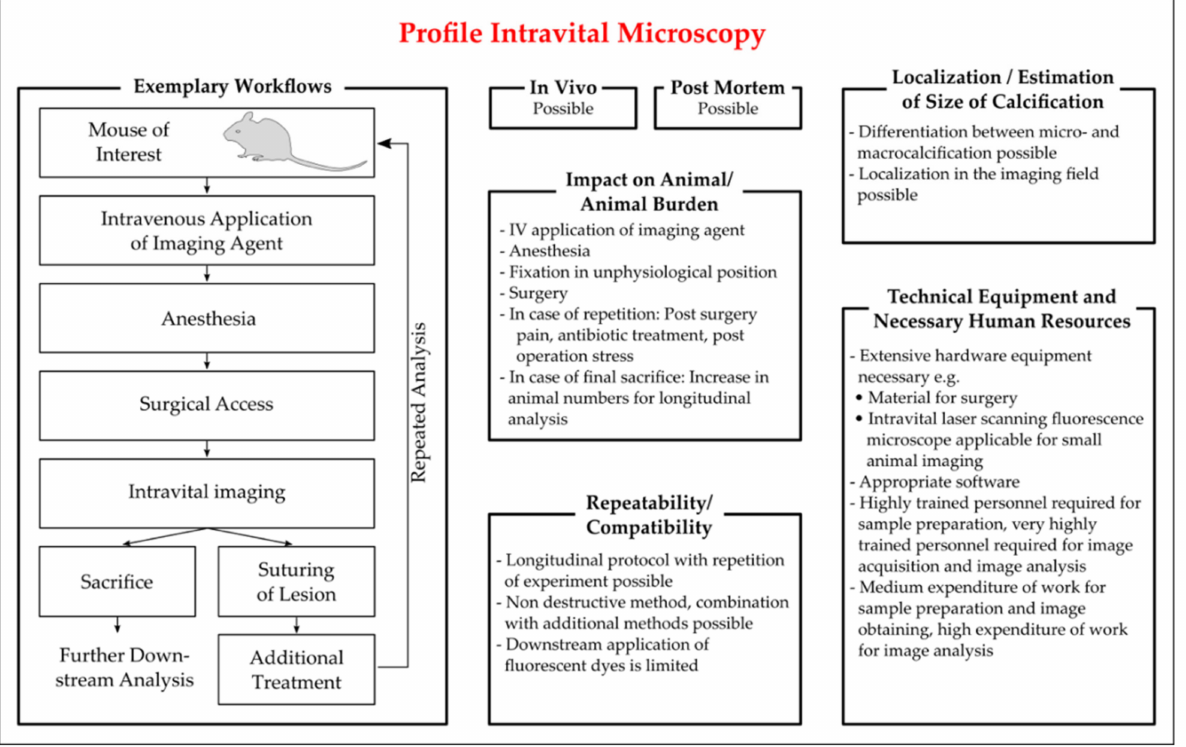
Figure 2. Characteristics of protocols of intravital microscopy (IVM) employed for the detection of vascular calcification in mice. Key aspects for the critical appraisal of the applicability of IVM are summarized with regard to the applicability of IVM in vivo and ex vivo, the location and size of vascular calcification identifiable by IVM, the repeatability of the read out in longitudinal studies, the compatibility with additional methods, and the personal and technical expanse. The exemplary workflow presented is based on the publications of